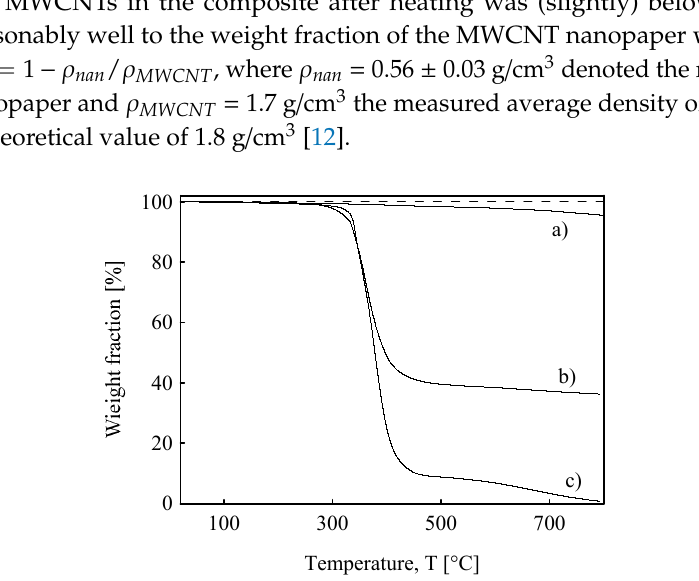
Figure 3. TGA curves of a ) the pure MWCNT nanopaper, b ) the MWCNT nanopaper/epoxy composite, and c ) the cured pure epoxy matrix.